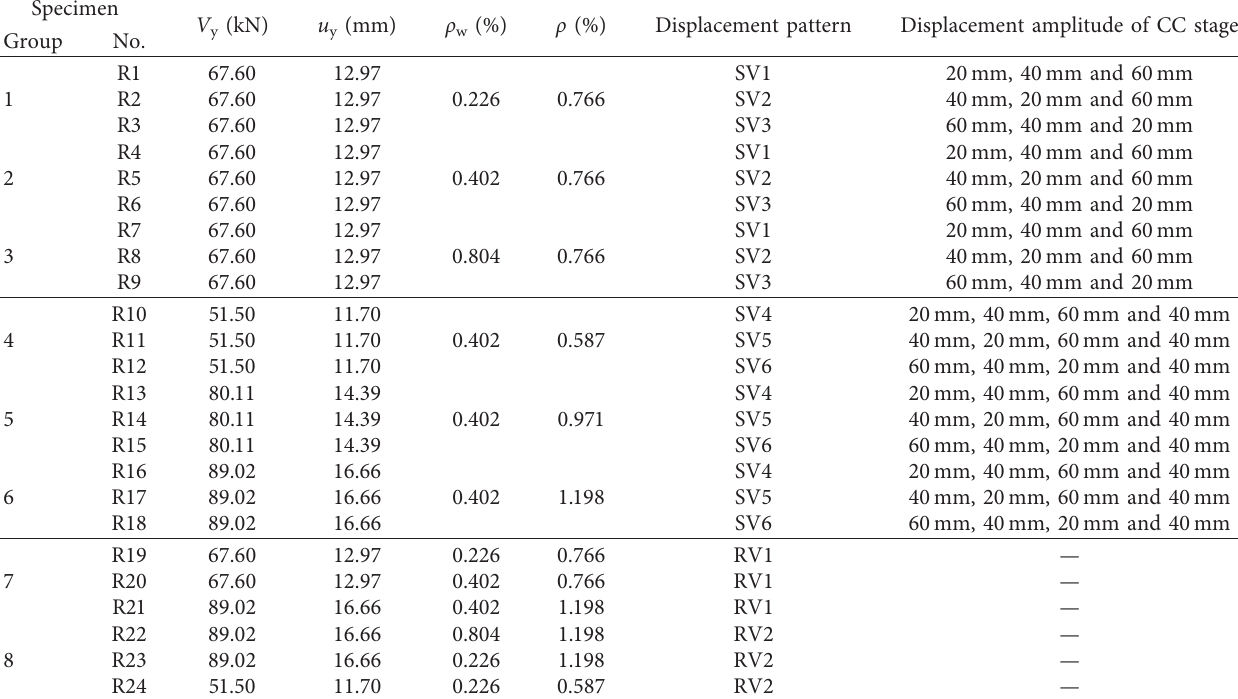
Table 1: The properties and imposed displacement patterns of 24 specimens [17].